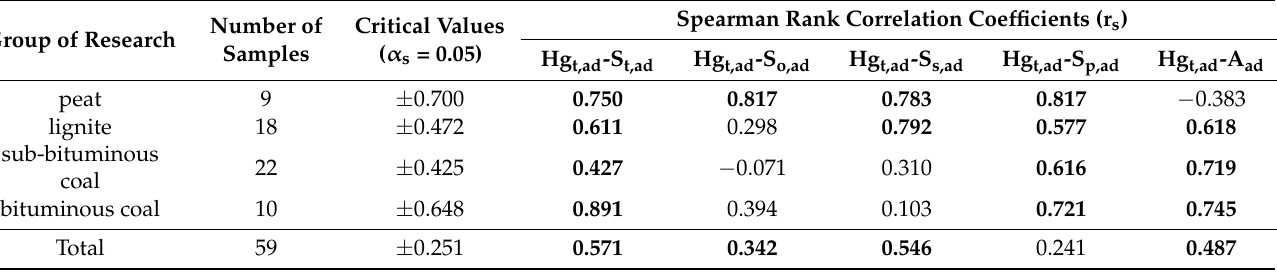
Table 6. Correlation coefficients (r s ) of Spearman rank correlation between Hg and other component in coal samples. Group of Research